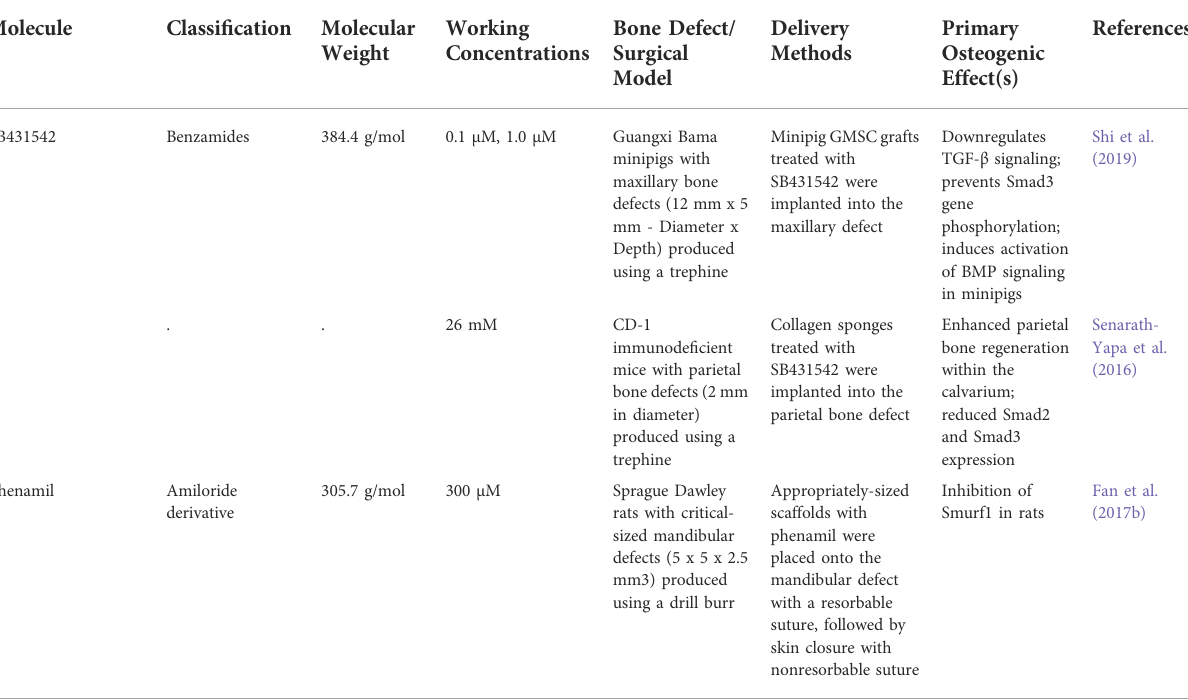
TABLE 2 Small molecular agents examined in vivo .